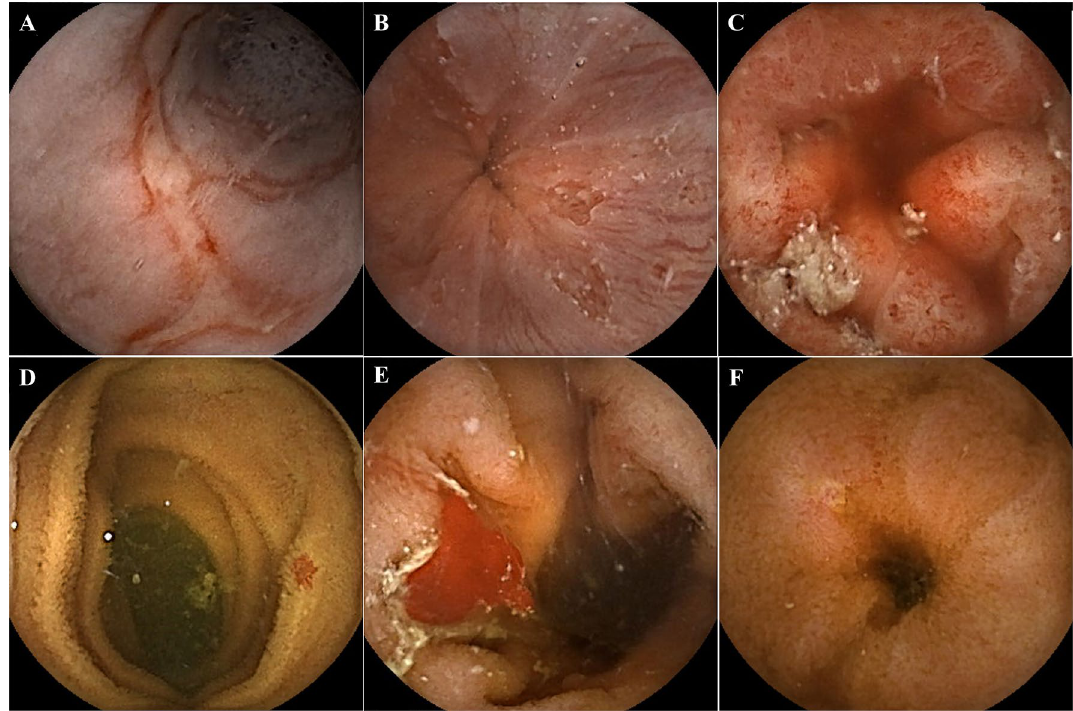
Figure 1. Gastrointestinal lesions identified by CE. ( A ) Reflux esophagitis, ( B ) SSBE, ( C ) GAVE, ( D ) Type 1b angioectasia, ( E ) Angioectasia with oozing ( F ) Erosion. CE: capsule endoscopy, SSBE: short segment Barrett’s esophagus, GAVE: gastric antral vascular ectasia.